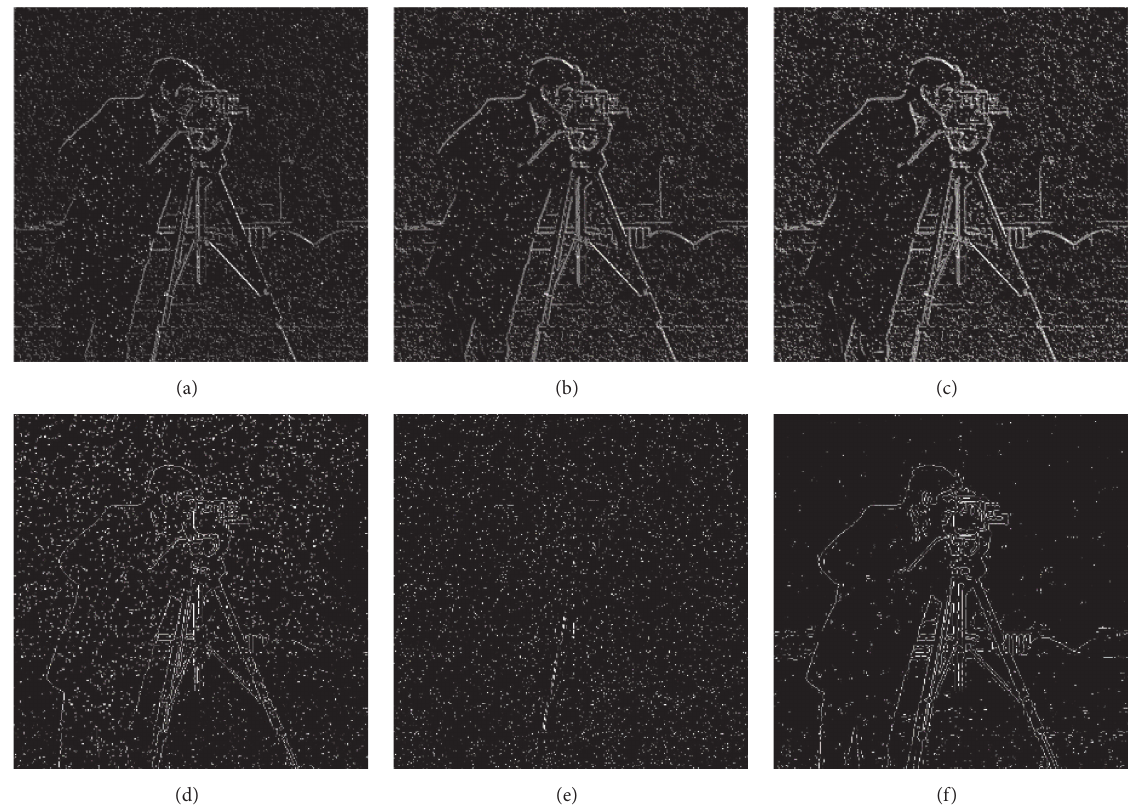
Figure 12: Cameraman with 3% salt and pepper: (a) SOM, (b) MOM, (c) LOM, (d) Sobel, (e) Roberts, and (f) Marr-Hildreth.